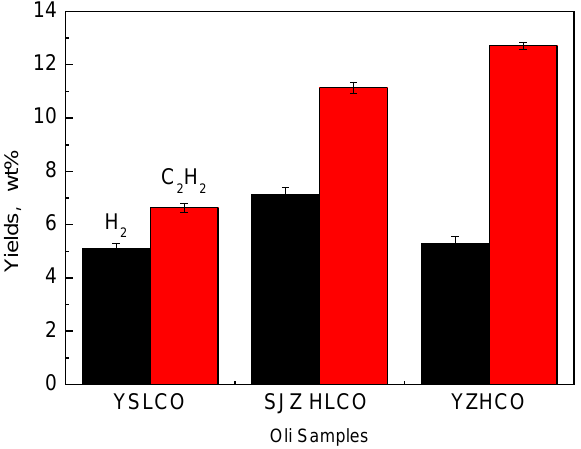
Figure 4. The main product yields of three